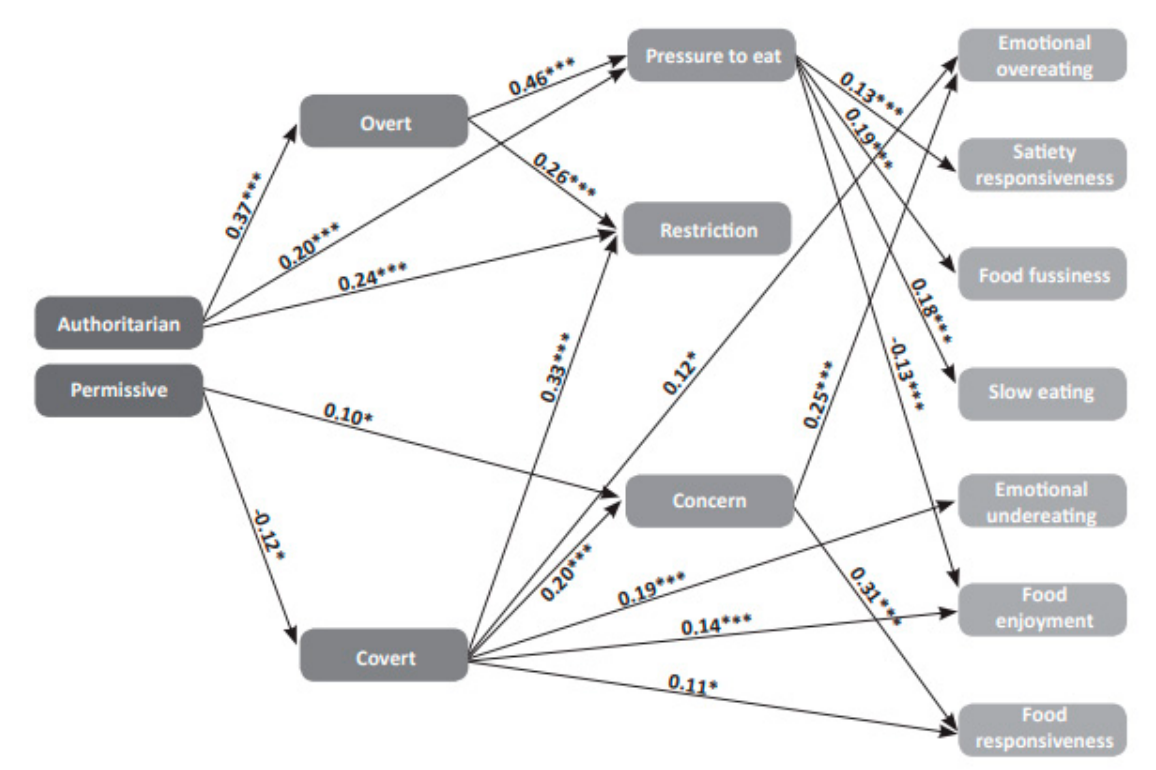
Figure 1. The mediating effect of child feeding practices on the relationship between maternal authority style and child eating behaviors. Note. * p < 0.05; ** p < 0.01; *** p < 0.001. Rectangles denote calculated subscales.